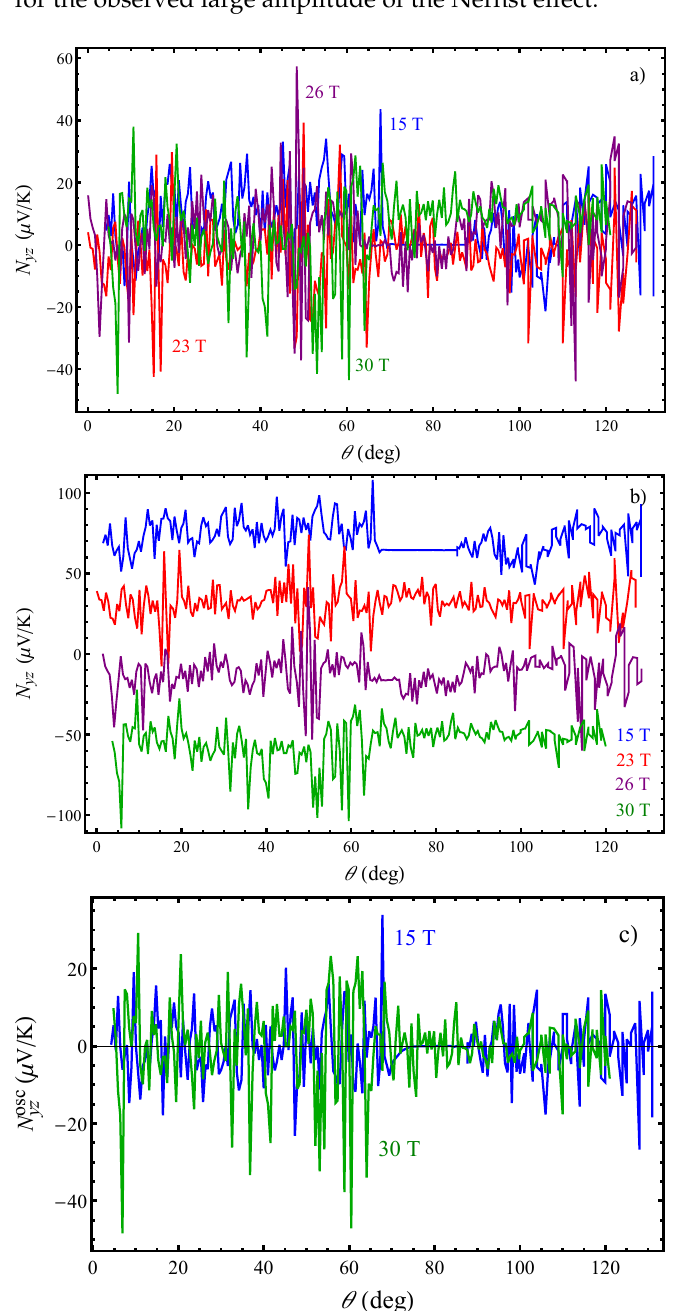
Figure 4. ( a ) Angular oscillations of the total Nernst effect in α - ( BEDT-TTF ) 2 KHg ( SCN ) 4 for several fields: B = 15 T, 23 T, 26 T and 30 T and T = 0.6 K. The Nernst effect quantum oscillations are visible at each magnetic field magnitude in the whole range of angles and are the dominant component in the total Nernst effect. ( b ) The Nernst effect oscillatory curves are shifted for clarity. ( c ) Angular quantum oscillations of the Nernst effect for T = 0.6 K at B = 15 T and B = 30 T differ in amplitude and phase, indicating that the system is driven from one into another CDW state with increasing field and tilt